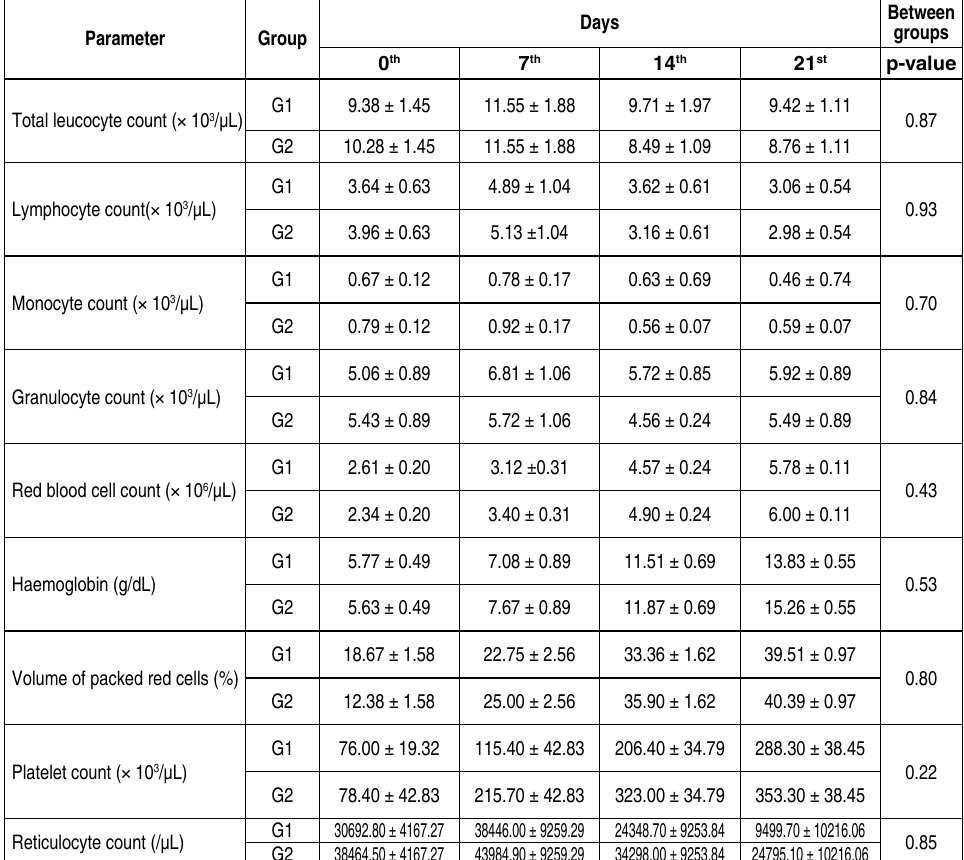
table 5 . Comparison of response to treatment between Group I and Group II